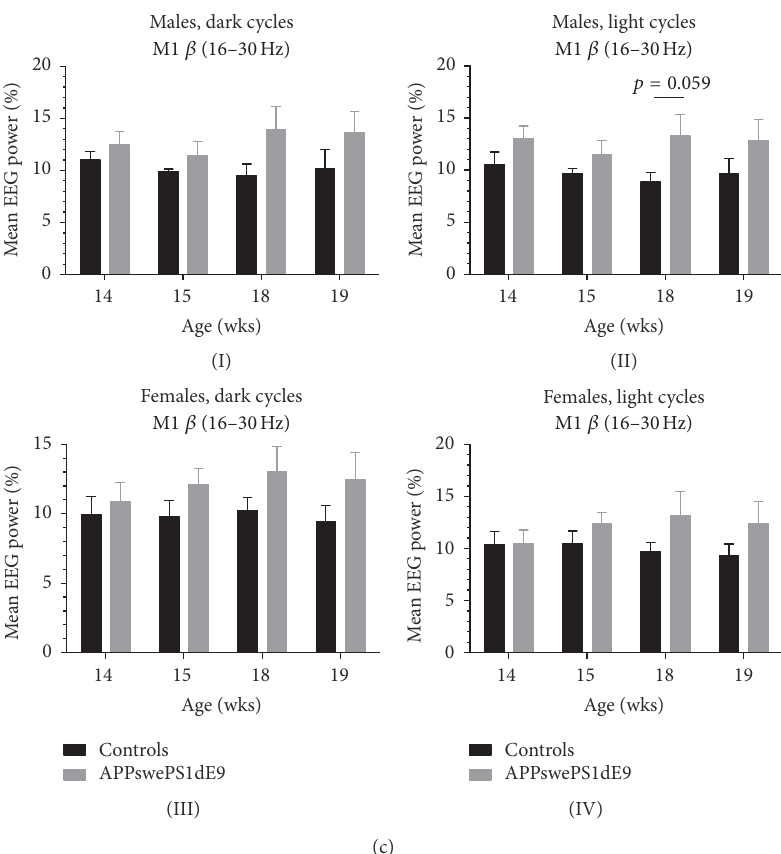
Figure 4: Frequency analysis in controls and APPswePS1dE9 mice. Using a FFT based approach, the mean EEG power [%] was calculated for males and females considering potential circadian rhythmicity (light/dark phase). For CA1 deflections, theta (4–8 Hz), gamma (30–50 Hz), and gamma (50–70 Hz) were quantified, for the cortical deflection delta (0.5–4 Hz) and beta (16–30Hz). Frequency analysis was performed for all four ages (14, 15, 18, and 19 wks). ∗ 𝑝 < 0.05 . ∗∗ 𝑝 < 0.01 . ∗∗∗ 𝑝 < 0.001